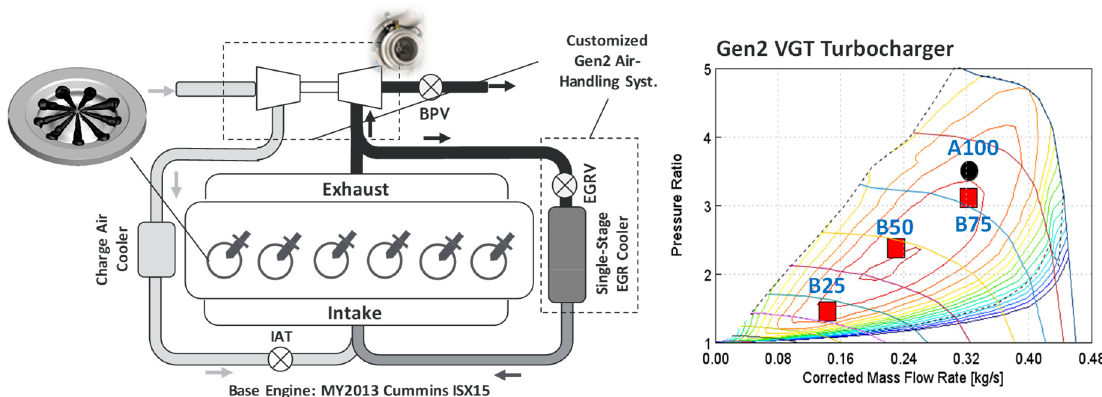
Figure 17. Gen2 GCI engine system layout.